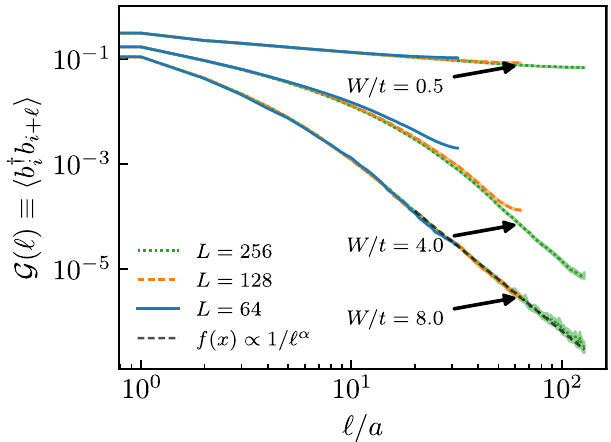
Fig. 2 Decay of the disorder-averaged one-body density matrix. G ð ‘ Þ as a function of distance ℓ for system sizes L = 64 (blue solid lines), 128 (yellow dashed lines), and 256 (green dotted lines), and values of the disorder strength W = 0.5, 4.0, and 8.0 (top to bottom). Data were shown on the doubly logarithmic scale. The gray dashed line corresponds to a power-law fi t 1/ ℓ α with α = 3.26(2) of the large distance behavior for L = 256 and W = 8.0. Vertical error bars indicate the estimated uncertainty from the Monte Carlo simulations and disorder-averages.